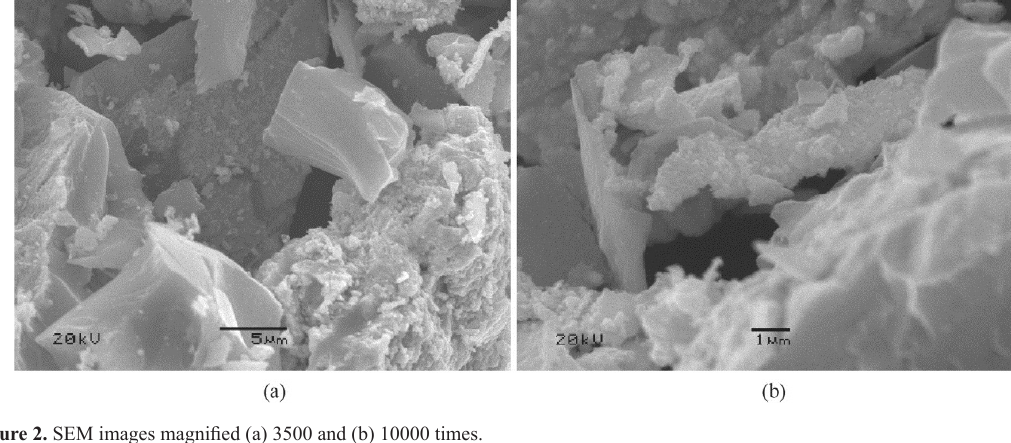
Figure 2. SEM images magnified (a) 3500 and (b) 10000 times.